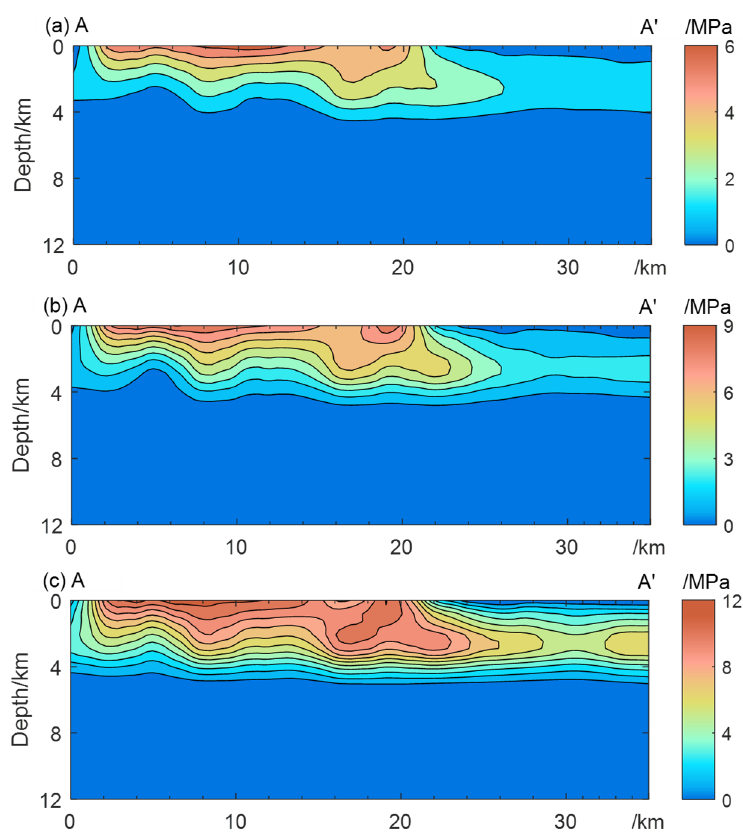
Figure 11. Pore pressure of A-A ′ profile under different water levels: ( a ) 135 m stage, ( b ) 156 m stage, and ( c ) 175 m stage.